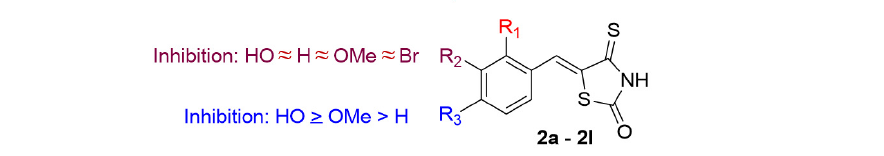
Figure 3. Structure–activity relationships of ( Z )-BTTZ derivatives 2a – 2l .